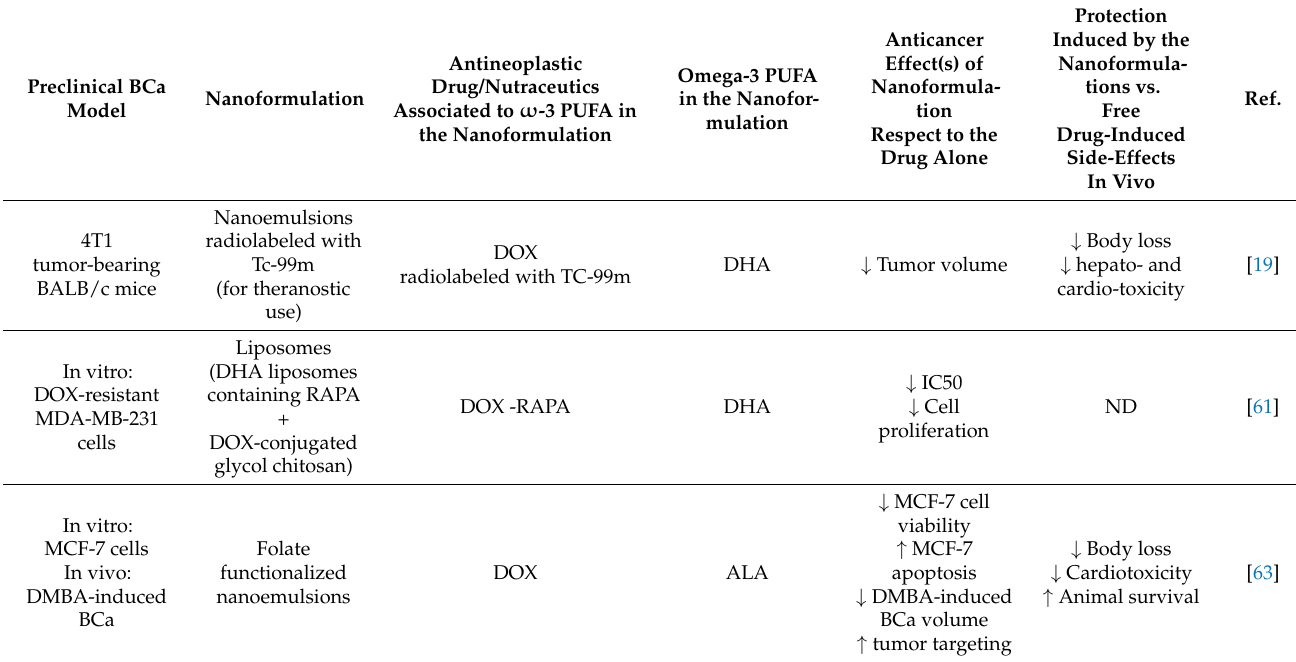
Table 1. Omega-3 PUFA containing nanosystems evaluated for BCa therapy